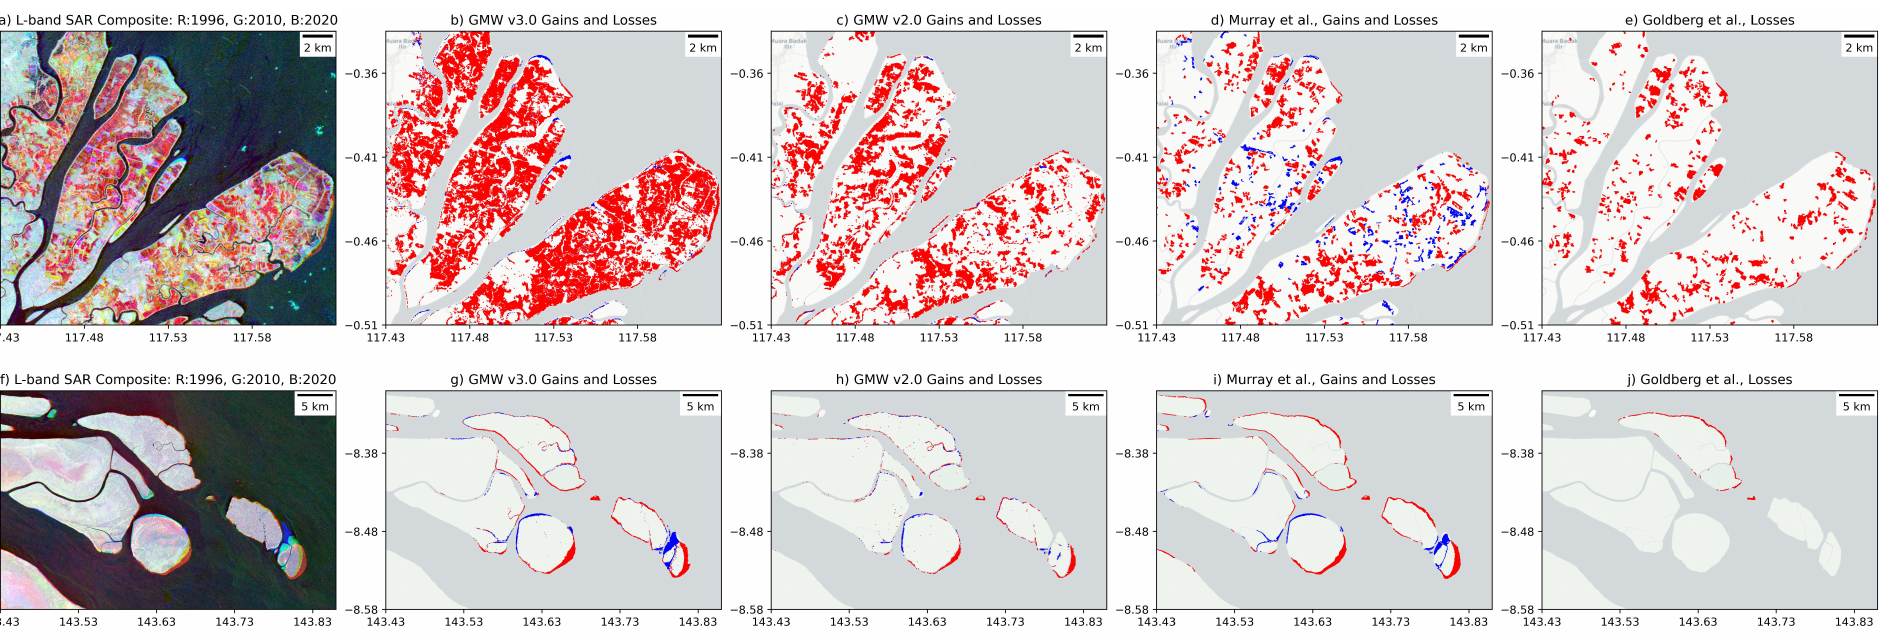
Figure 12. Visual comparison of this study compared to the L-band SAR data and the GMW v2.0 [25], Murray et al. [13] and Goldberg et al. [12] datasets. Mangroves for an area of loss due to aquaculture in East Kalimantan, Indonesia ( a – e ) and a dynamic river estuary in Papua New Guinea ( f – j ) are shown. The Red and Yellow regions in the SAR images ( a , f ) correspond with loss, Blue with gain and White and Black as no change. Within the mangrove maps ( b – e , g – j ) Blue represents detected mangrove gains and Red represents detected